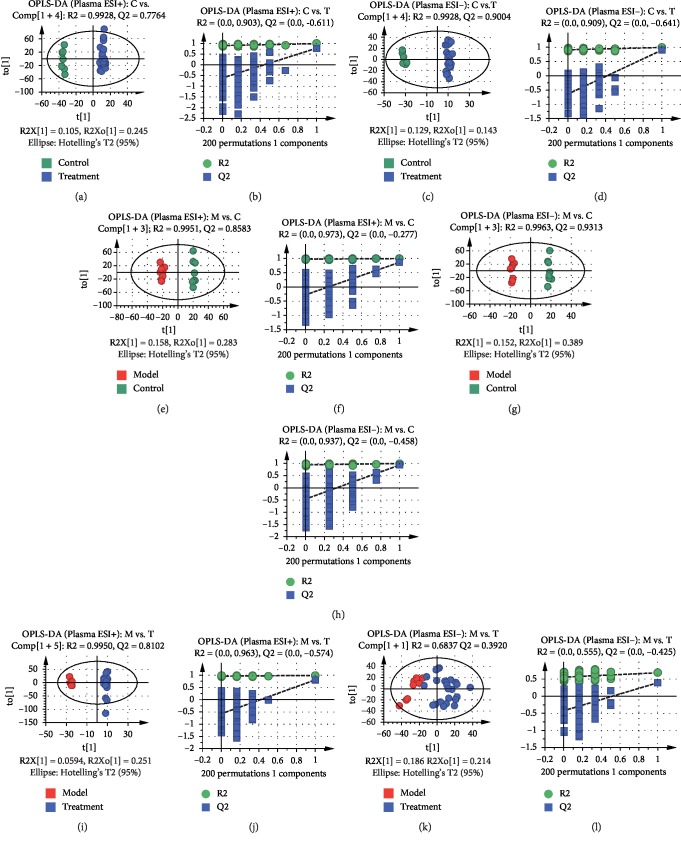
OPLS-DA score plots and permutation test results of metabolomics analysis based on plasma samples: results between the control group and the RWCI treatment groups in the ESI+ mode (a, b) and in the ESI− mode (c, d); results between the model group and the control group in the ESI+ mode (e, f) and in the ESI− mode (g, h); results between the model group and the RWCI treatment groups in the ESI+ mode (i, j) and in the ESI− mode (k, l). All P values were less than 0.01, calculated by the CV-ANOVA test.